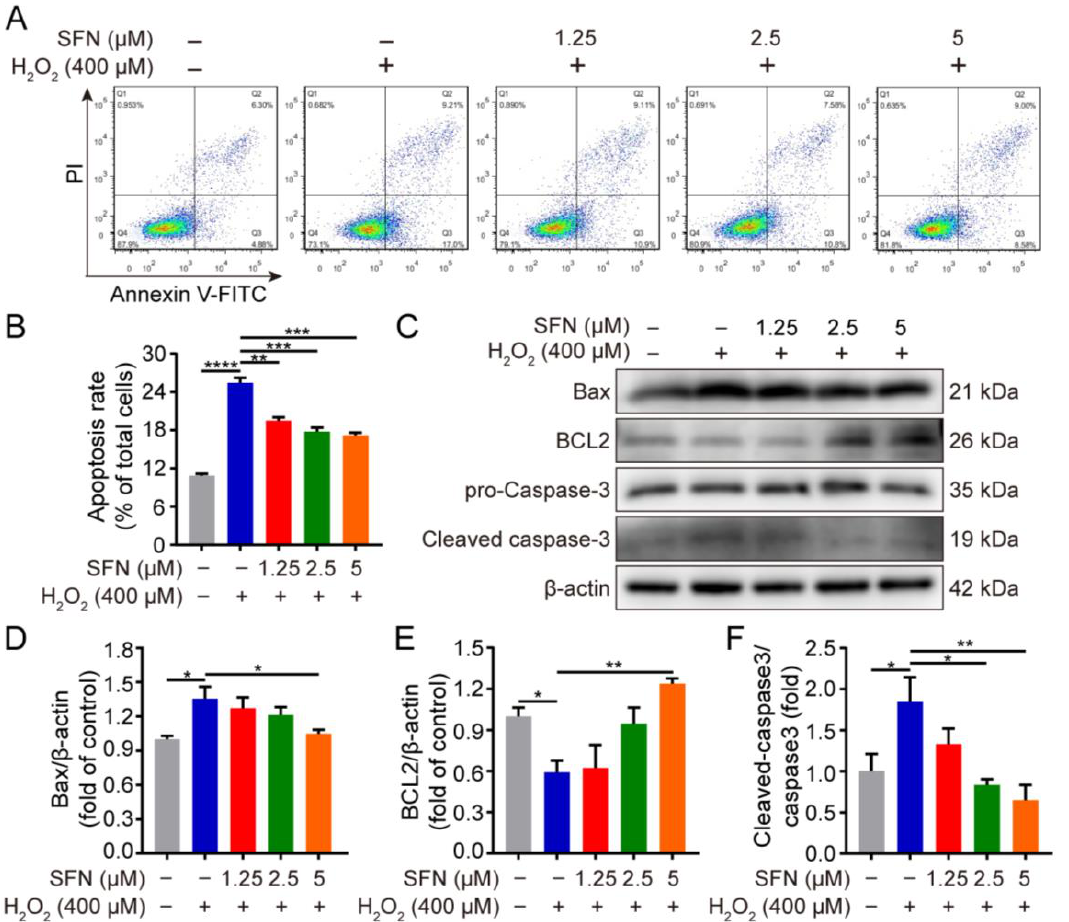
Figure 2. SFN suppresses H 2 O 2 -induced apoptosis. GMECs were treated with SFN for 24 h following H 2 O 2 treatment. ( A ) Detection of apoptosis using annexin V-FITC and PI staining assay through flow cytometry. ( B ) Statistical analysis of the apoptotic rate. ( C ) Western blot analysis of recombinant BCL2 associated X protein (Bax), B cell leukemia/lymphoma 2 (BCL2), procaspase-3, and cleaved caspase-3 protein expression. ( D ) Quantitative analysis of Bax protein level. ( E ) Quantitative analysis of BCL2 protein level. ( F ) Quantitative analysis of cleaved caspase-3/procaspase-3 protein level. One-way ANOVA, Tukey’s post hoc test. Data are the mean ± SEM ( n = 3). * p < 0.05, ** p < 0.01, *** p < 0.001, and **** p < 0.0001.